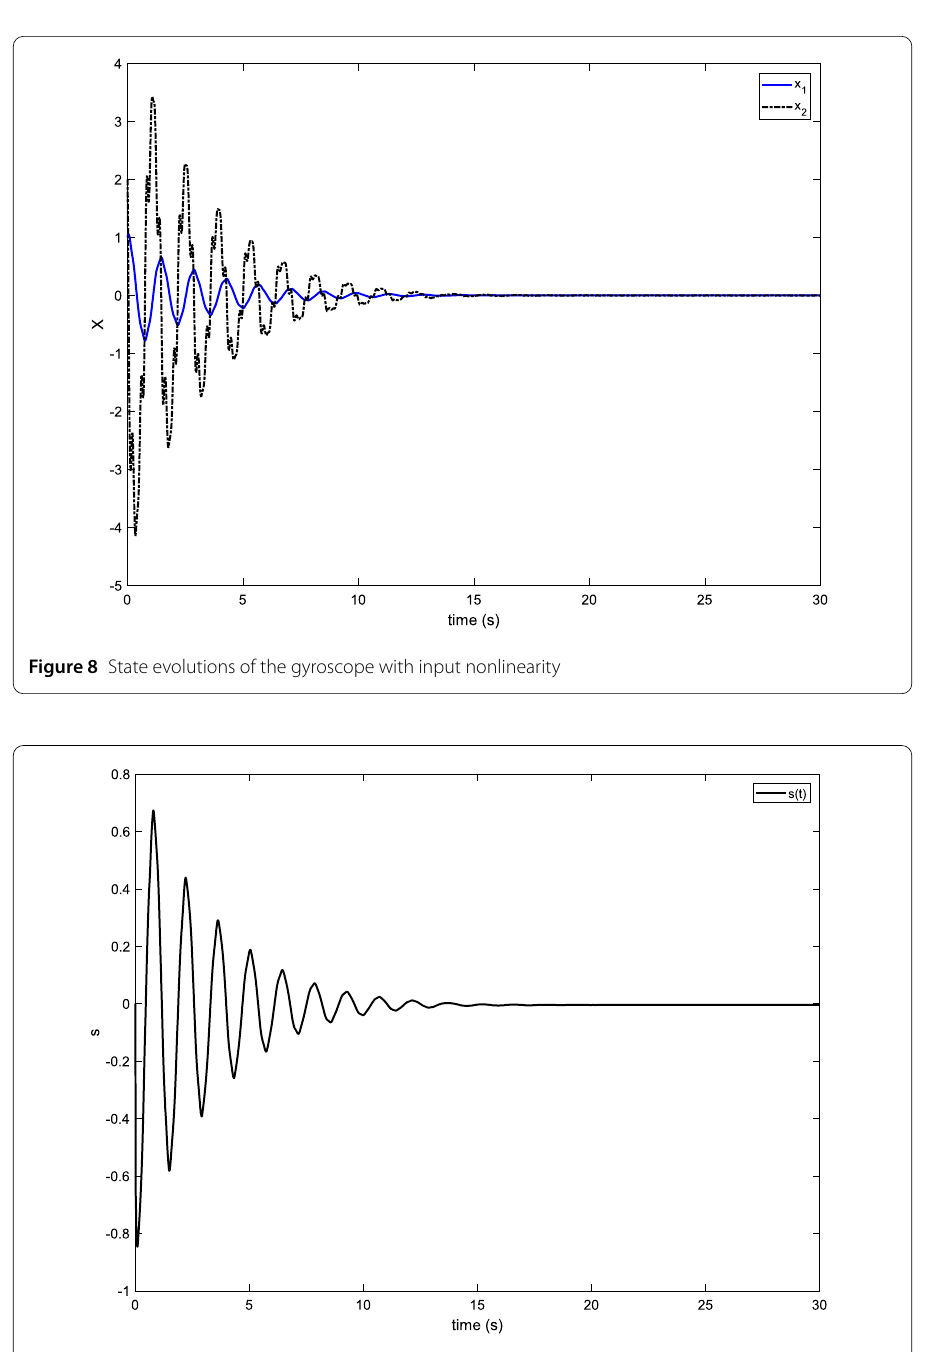
Figure 9 Time evolution of the sliding manifold